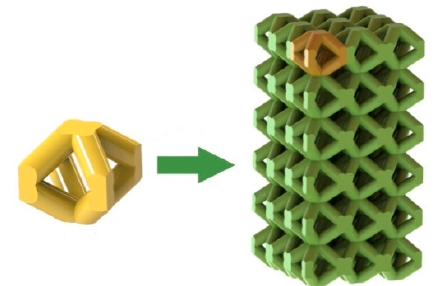
Figure 1. Schematic of designing process for the body-centered cubic (BCC) porous structure.